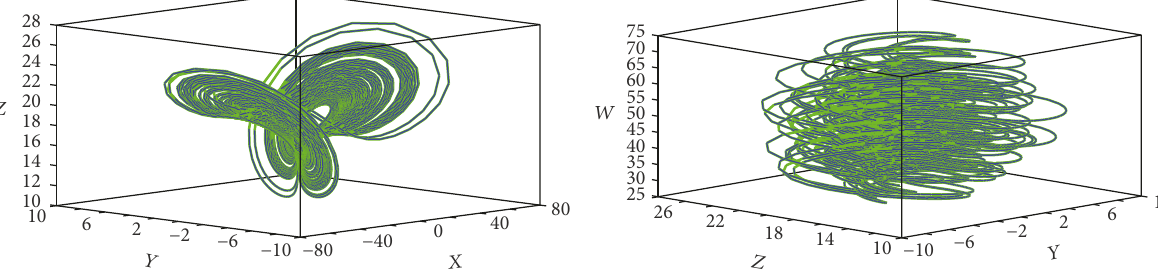
Figure 13: 3D phase portraits of NCS ( 𝑎 = 0, 𝑏 = 0 ).